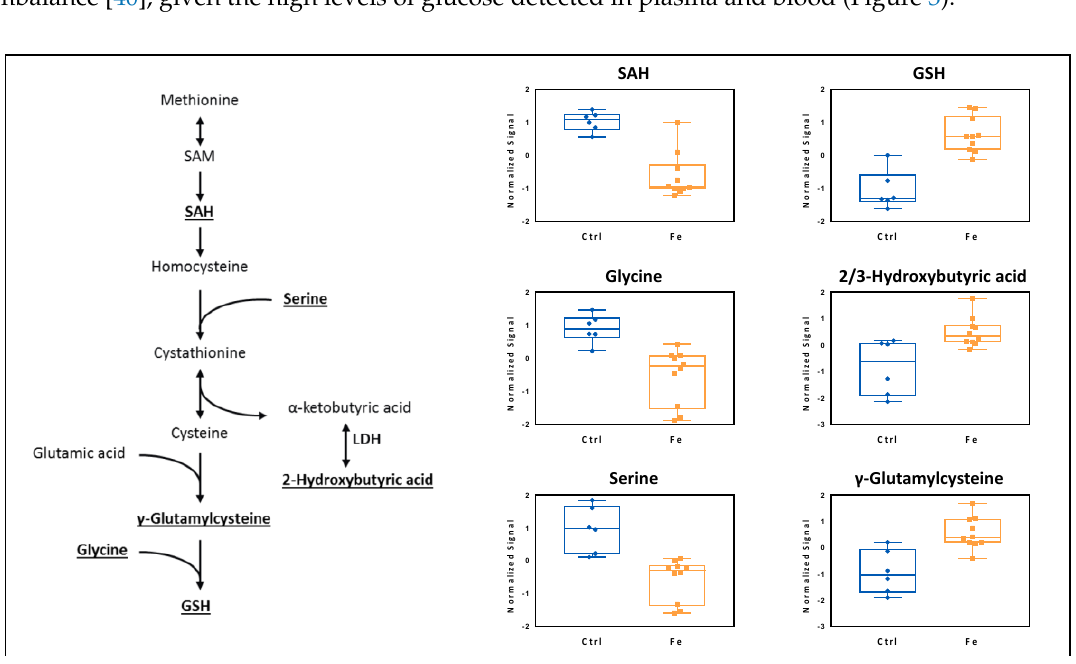
Figure 4. Metabolic profiling of the liver upon iron challenge. Dietary iron loading affects the transmethylation pathway, driving glutathione synthesis and production of 2-/3-hydroxybutyric acid. SAM: S-adenosyl-L-methionine; SAH: S-adenosylhomocysteine; LDH: Lactate dehydrogenase; GSH: Glutathione. Controls (Ctrl, blue, n = 3), high-iron diet (Fe, orange, n = 5). Each sample was run in duplicates. Statistics: Student t -test was performed, a p -value < 0.05 was considered to be significant. Table 3. Metabolites significantly changing (increasing ↑ , decreasing ↓ ) in liver after two weeks of a high-iron diet as compared to control animals. Controls (Ctrl, blue, n = 3), high-iron diet (Fe, orange, n = 5). Each sample was run in duplicate. Statistics: student t -test was performed, fold-change was calculated and a p -value < 0.05 was considered to be significant.